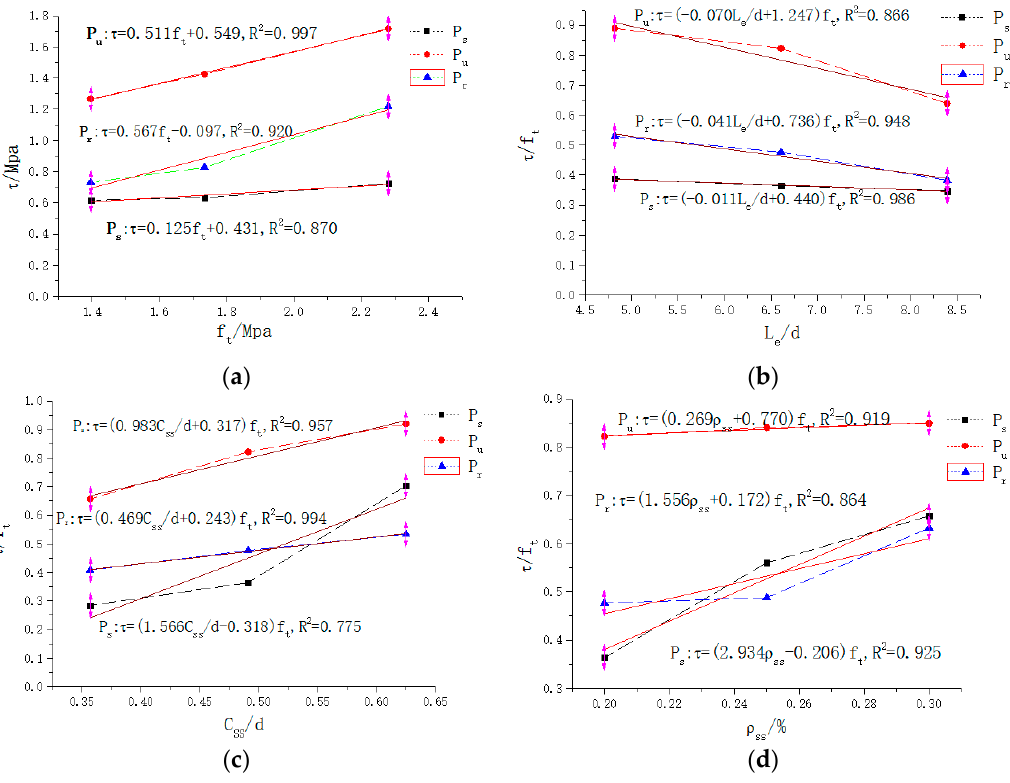
Figure 8. Relationship of bond strength and various factors: ( a ) concrete strength; ( b ) embedded length; ( c ) cover thickness; ( d ) lateral stirrup ratio.